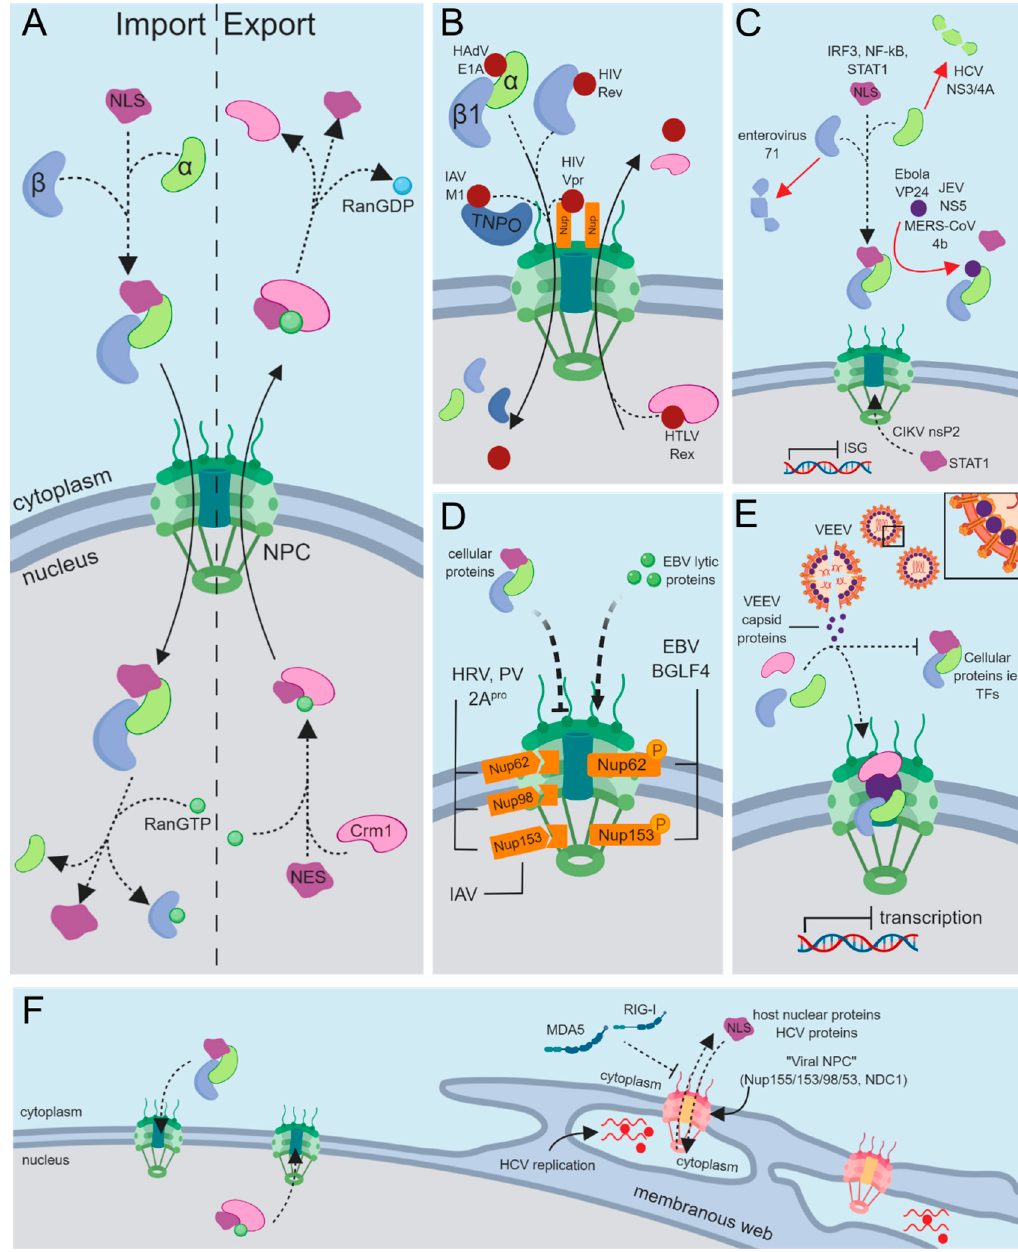
Figure 1. Viral appropriation of cellular nucleocytoplasmic transport. ( A ) Classical protein nuclear import mediated by Importin- α (Imp- α ; green) and Importin- β (Imp- β ; blue), and nuclear export pathways mediated by Crm1 (pink). ( B – F ) Selected examples of viruses perturbing or